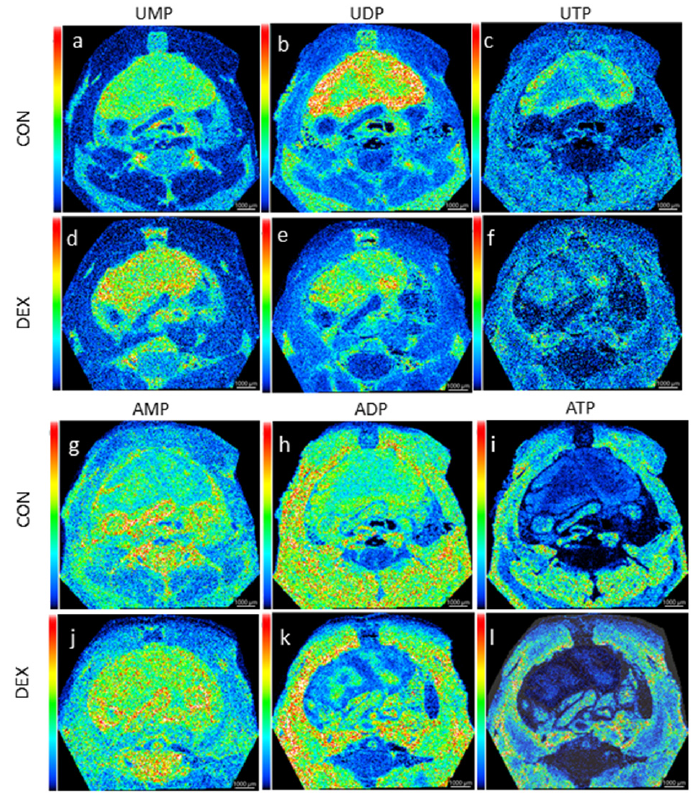
with or without DEX treatment for the mice [34] where adenosine monophosphate (AMP) at m / z 346.04.